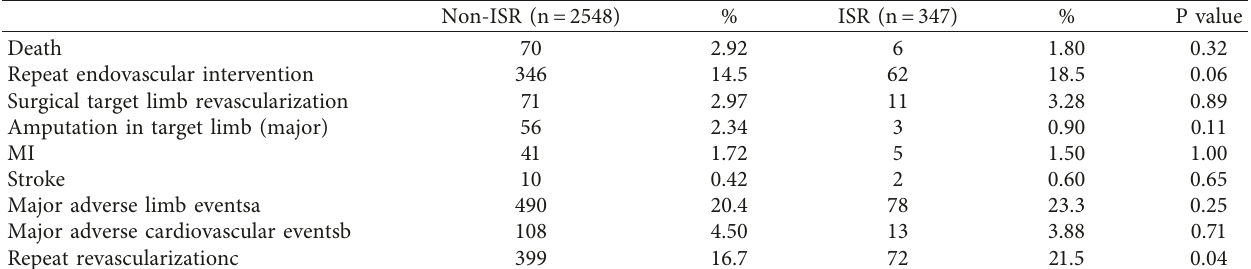
Table 5: 1-year outcomes for femoropopliteal (FP) non-in-stent restenosis and in-stent restenosis (ISR) groups. Non-ISR (n �